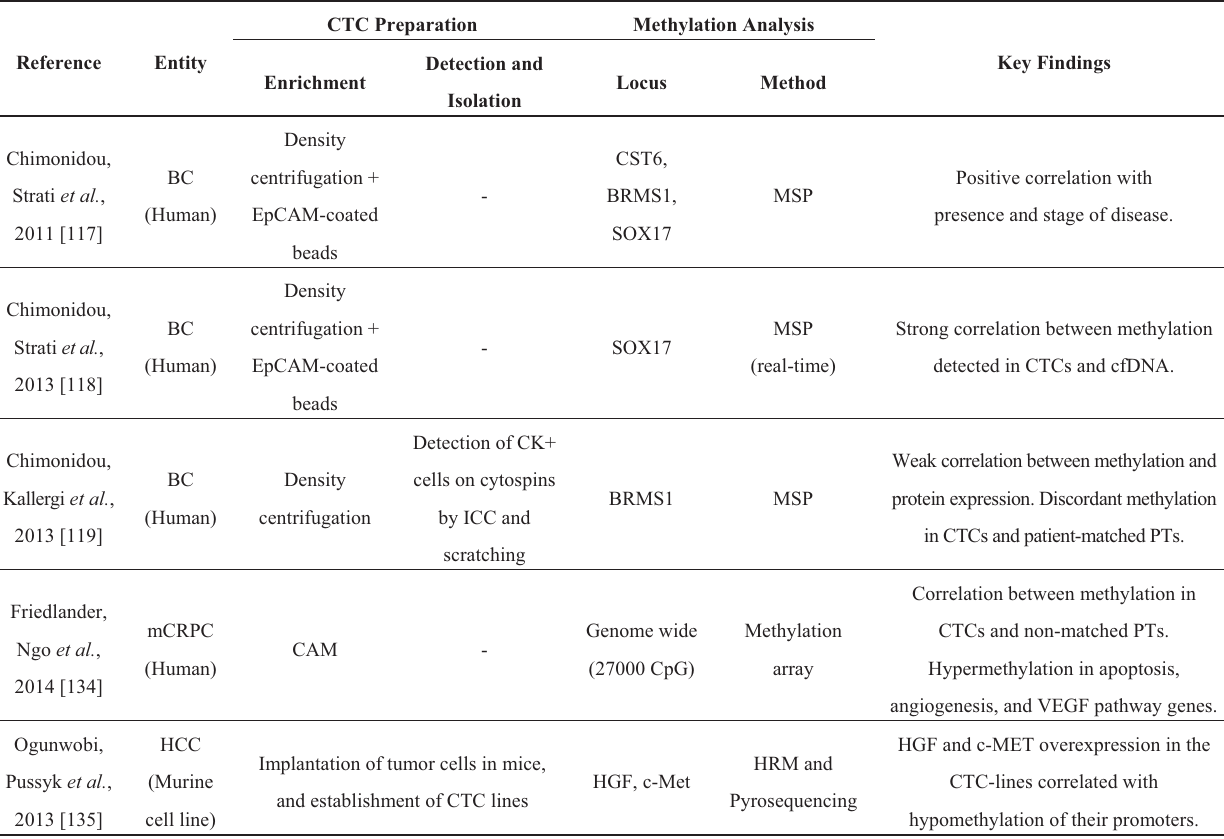
Table 1. Technical details and key findings of publications addressing DNA methylation in